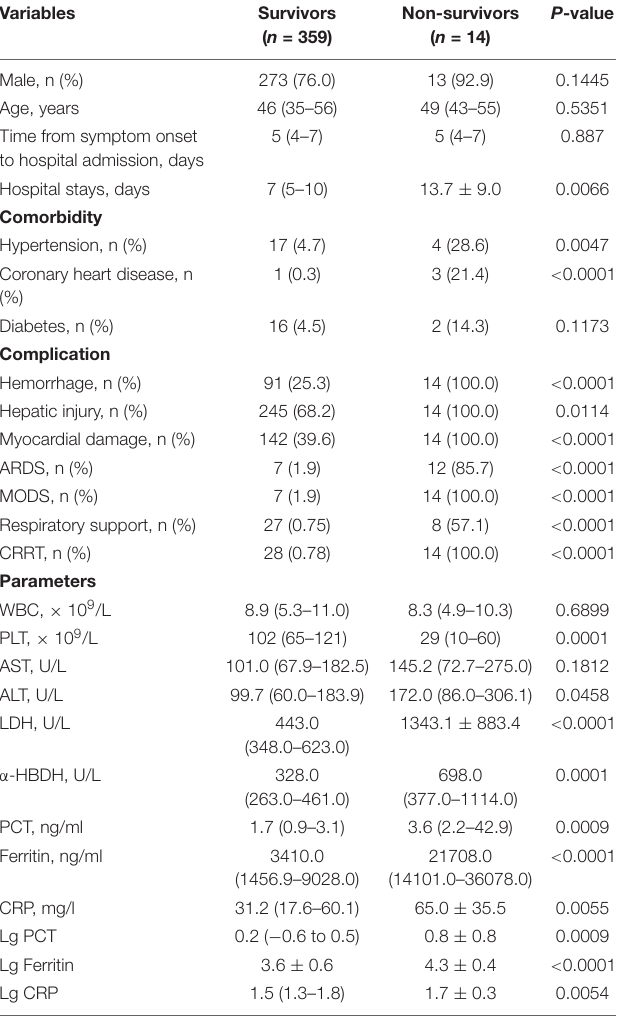
TABLE 6 | Demographics and clinical and laboratory data at admission in survivors and non-survivors of patients with HFRS*. Variables